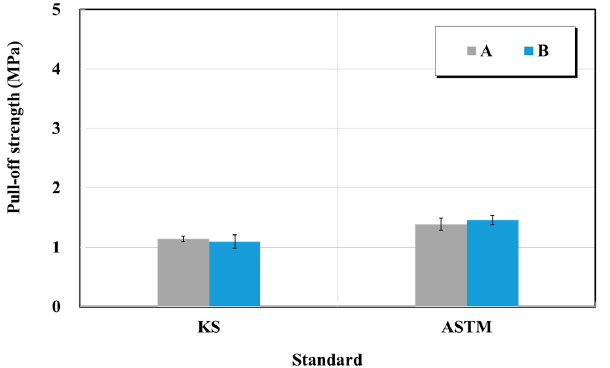
Figure 10. Bond strength test results of structure restoration material (repair mortar) obtained based on the KS and ASTM